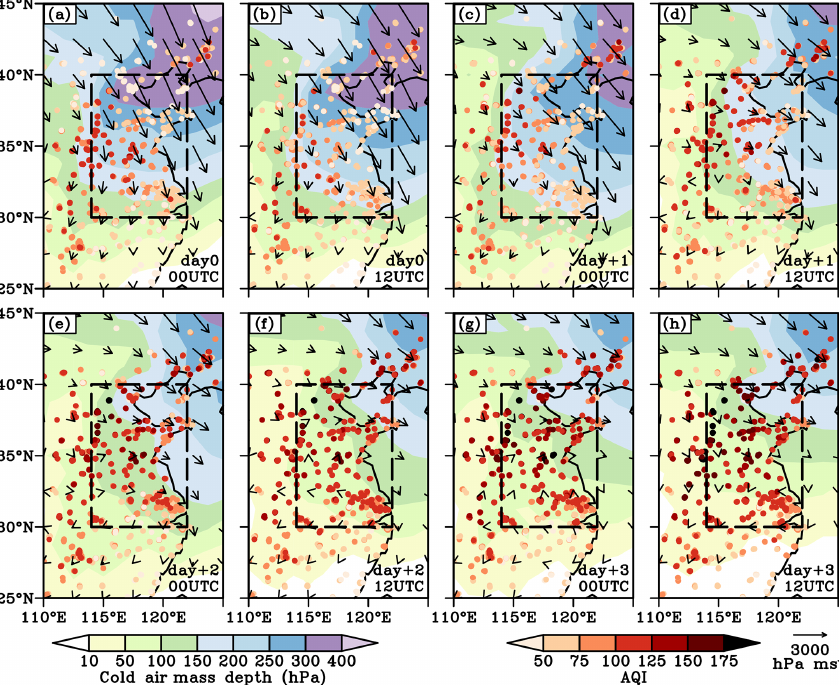
Figure 5. Spatial distributions of the composited cold air mass depth (shaded), horizontal fluxes of the cold air mass (black vectors), and AQI (colored dots) during CAO_rapid events. The black boxes denote the NEC (114–122 ◦ E, 30–40 ◦ N).